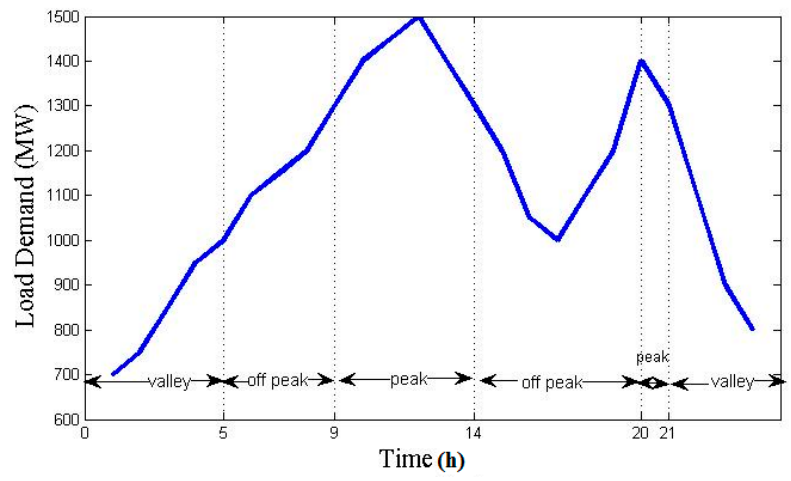
Figure 2. Valley, off peak and peak load unit operating system.